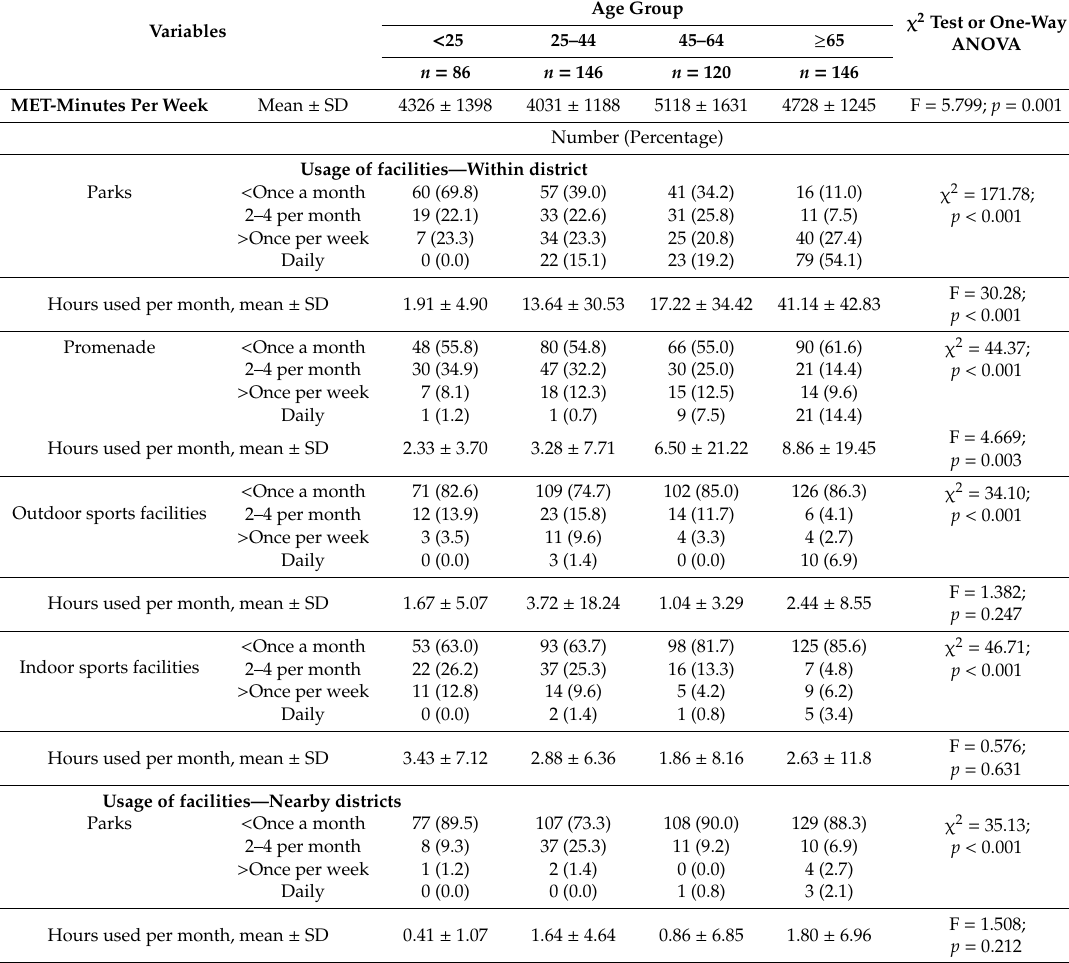
Table 5. The usage of within and nearby district facilities by active participants of di ff erent age